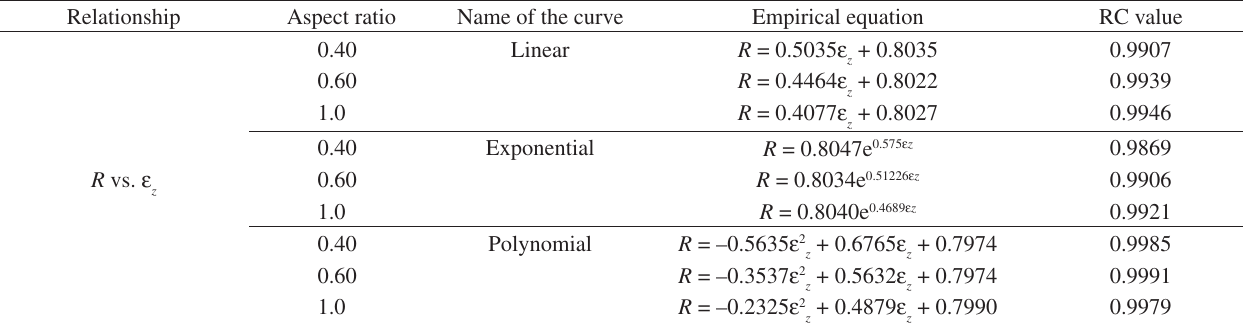
Figure 3. a) Relationship between R and e and d) relationship between R and e Table 2. Curve fitted results between R and e